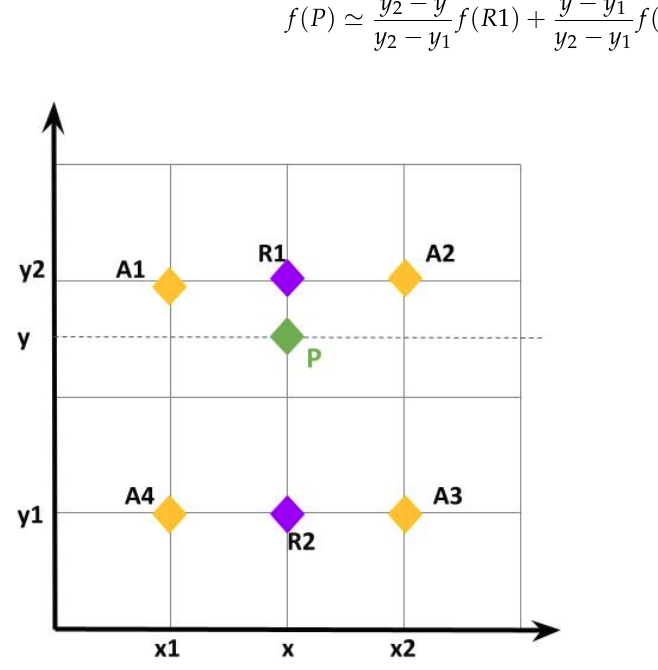
Figure 4. The bilinear